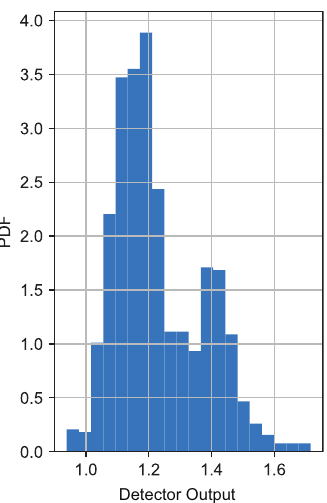
Figure 10. Detector output’s emprical